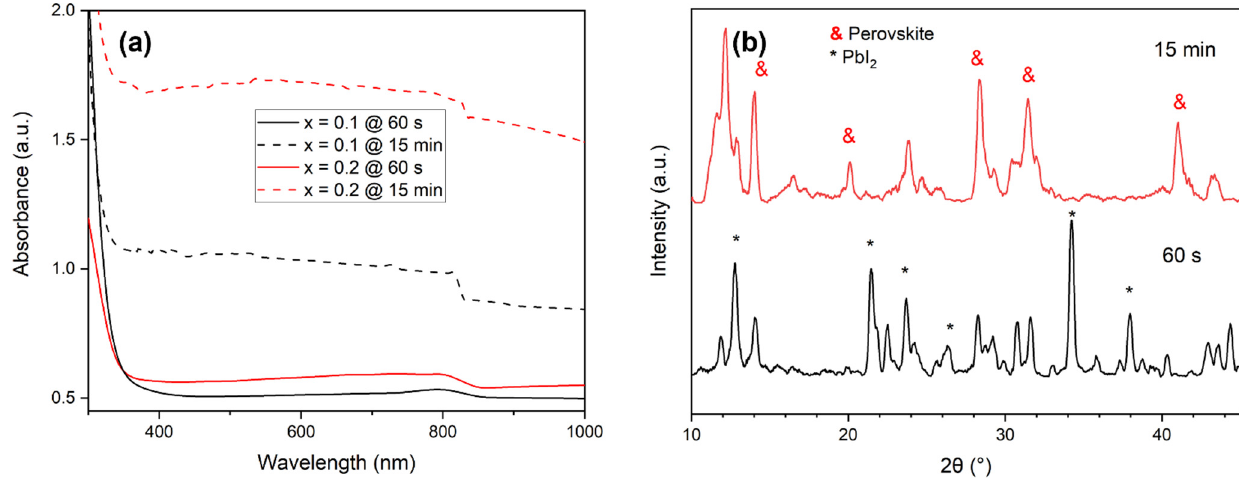
Figure 1. ( a ) Absorbance spectra of the FA 0.8 Cs 0.2 PbI 3 − x Br x perovskite layers, where x represents the molar ratio of Br. ( b ) XRD patterns of Br-0.2 after increasing the dipping time from 60 s up to 15 min. The red ampersand denotes the perovskite peaks, while the black asterisk is a label for PbI 2 peaks.